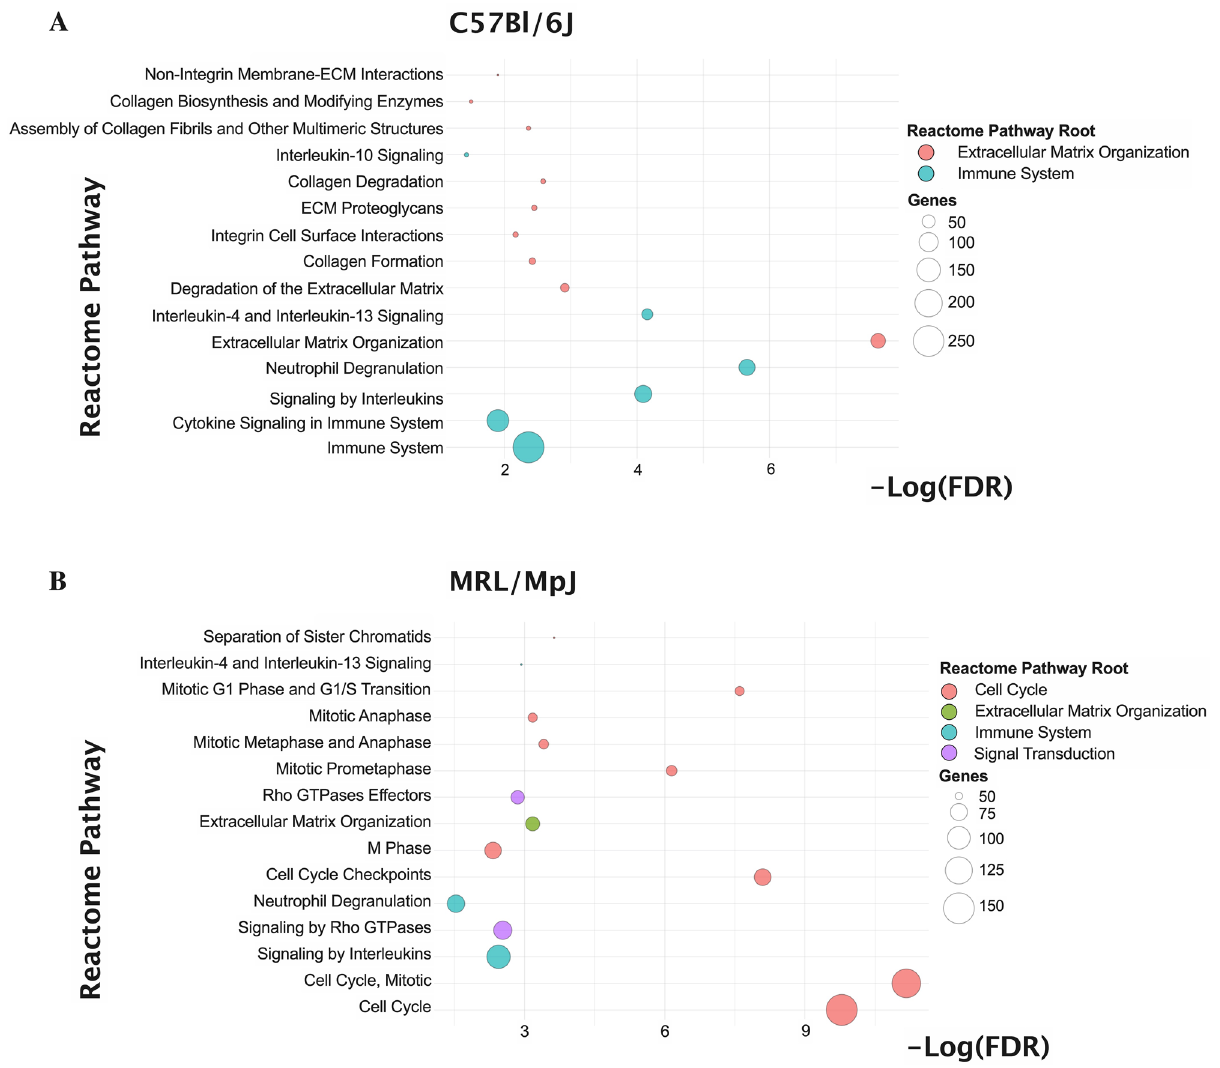
Figure 5. Bubble plots of the top 15 Reactome pathways enriched in the injured C57 tendon ( A ) and the MRL tendon ( B ), respectively. Bubble fill color represents the Reactome Pathway Root, while the size of the bubble represents -Log 10 (FDR) in A & B and the number of genes represented in the enriched pathway in C&D,